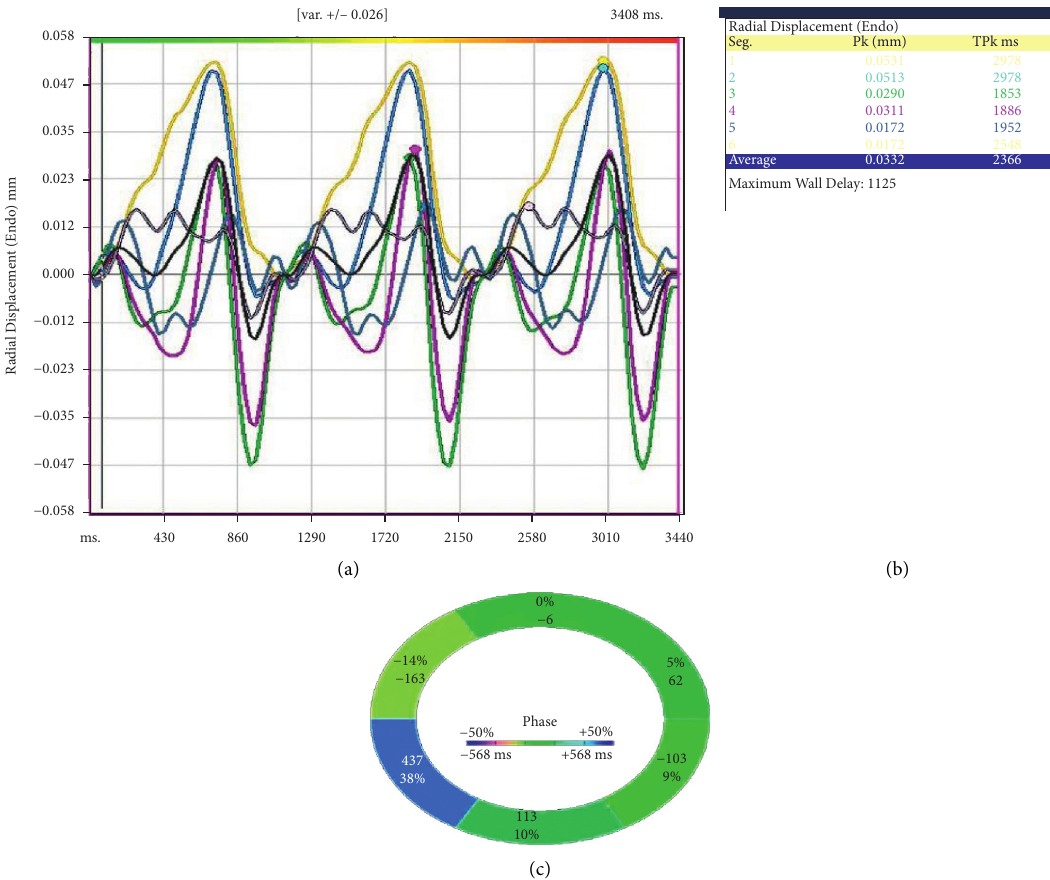
Figure 2: Poststent coronary artery vessel wall radial deformation. Example of syngo ® software output for radial deformation (dis- placement) values over three full cardiac cycles. The colored curves represent regional deformation in a six-segment model of the coronary vessel. The black curve represents the averaged deformation of all of the individual segments.